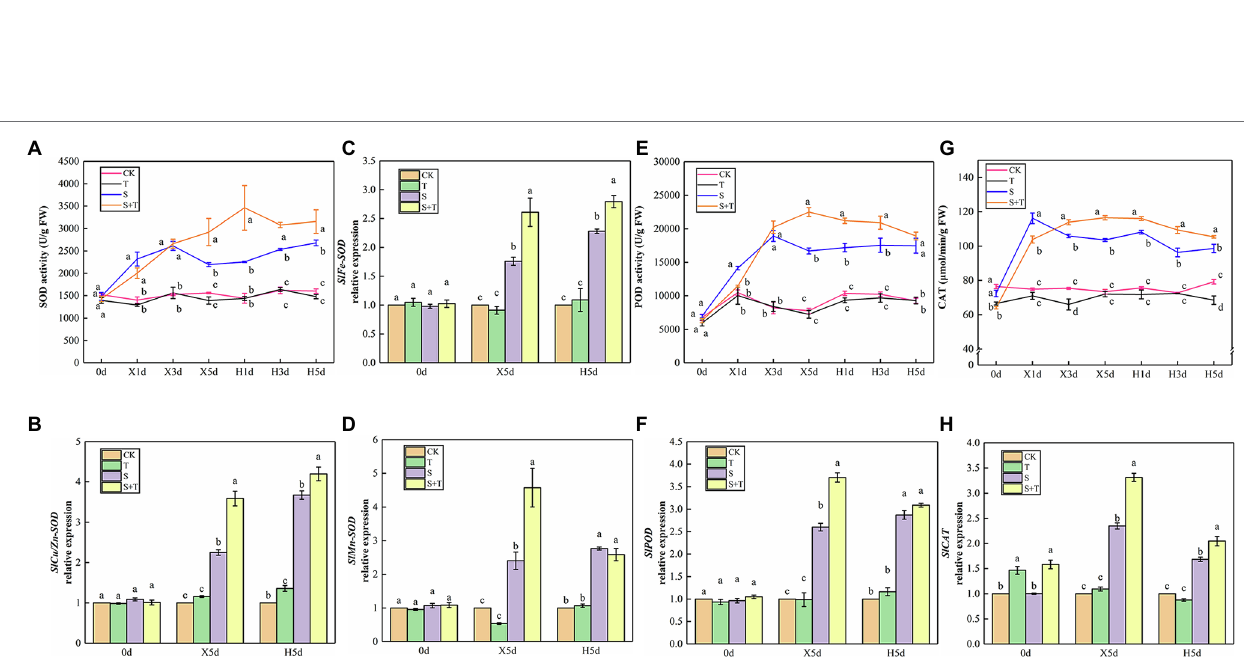
FIGURE 9 | Impact of exogenously applied trehalose on ROS metabolism of tomato leaves under stress and non-stress conditions. (A,E,G) represent the activity of SOD, POD and CAT, respectively. (B–D,F,H) represent the expression levels of SlCu/Zn-SOD , SlFe-SOD , SlMn-SOD , SlPOD , and SlCAT , respectively. The results showed the mean ± SE of three replicates, and the different letters denote the significant difference among treatments ( p < 0.05), according to Duncan’s multiple test. CK, control; T, 10 mM trehalose; S, 150 mM NaCl; S + T, 150 mM NaCl +10 mM